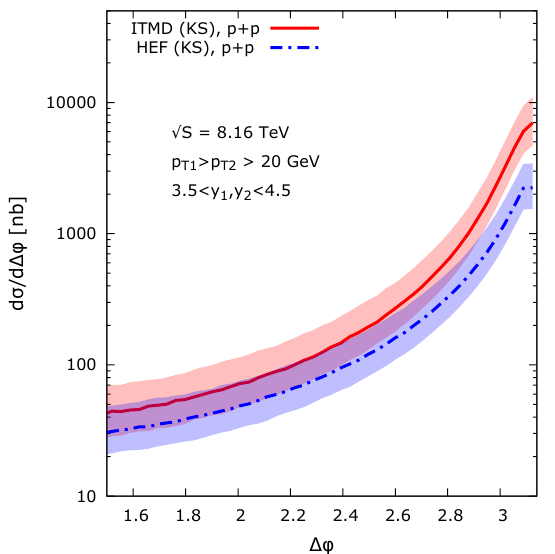
Figure 1 . Di(cid:11)erential cross section as a function of the azimuthal angle between the jets for p+p collisions, comparing the new ITMD approach with previously obtained HEF results. The plot replaces (cid:12)gure 3 left in [1].